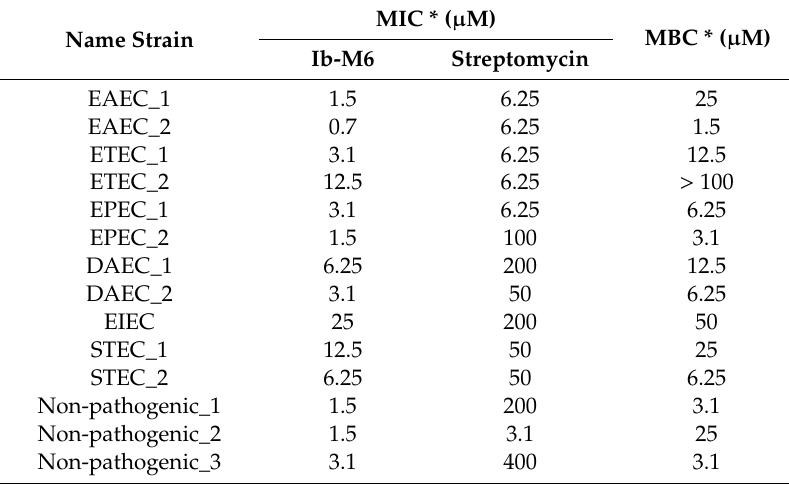
Table 1. The Minimum Inhibitory Concentration (median values, n = 3) and the minimum bactericide concentration (median values, n = 3) of Ib-M6 peptide on Escherichia coli strains. MIC * ( µ M) MBC * ( µ M) Name Strain